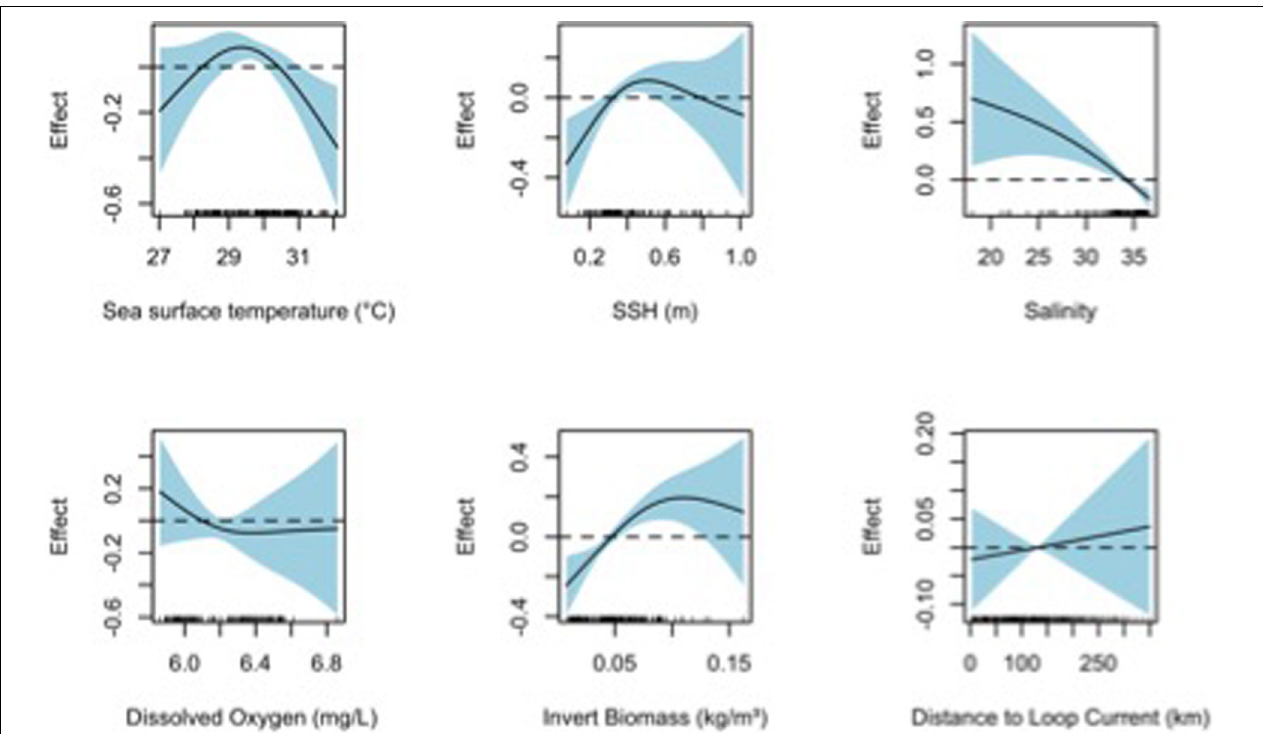
FIGURE 6 | Response plots for 2016 oceanographic variable of the bongo net taxonomic richness ( T F ) from full generalized additive model (GAM). Plots include sea surface temperature ( ◦ C), sea surface height (m), salinity, dissolved oxygen (mg L − 1 ), invertebrate biomass (kg m − 3 ), and distance to Loop Current (km). Solid lines represent smoothed values and the shaded area represents 95% confidence intervals. Dashed line displayed at y = 0 on response plots.